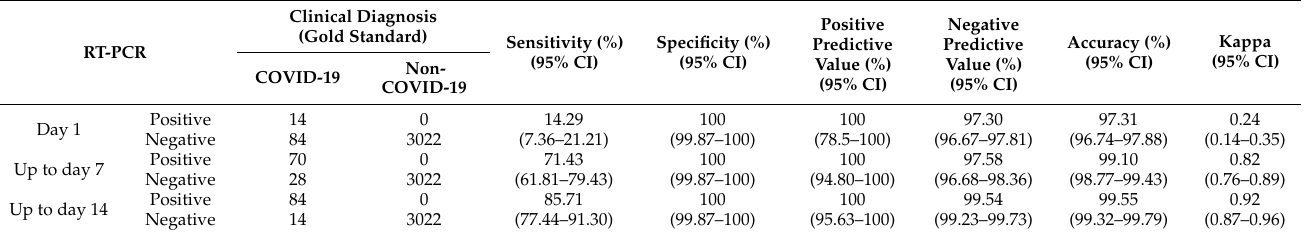
Table 1. Diagnostic performance of the first RT-PCR test for COVID-19 based on clinical diagnosis. Clinical Diagnosis (Gold RT-PCR